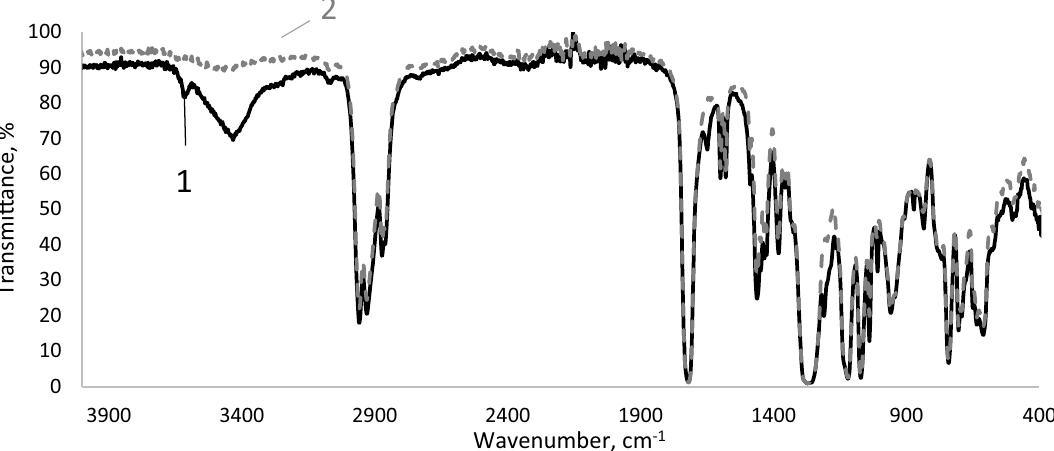
Figure 1. Full-infrared spectrum of PVC plastisol membranes containing cadmium yellow (CdS) before (1) and after (2) UV irradiation.